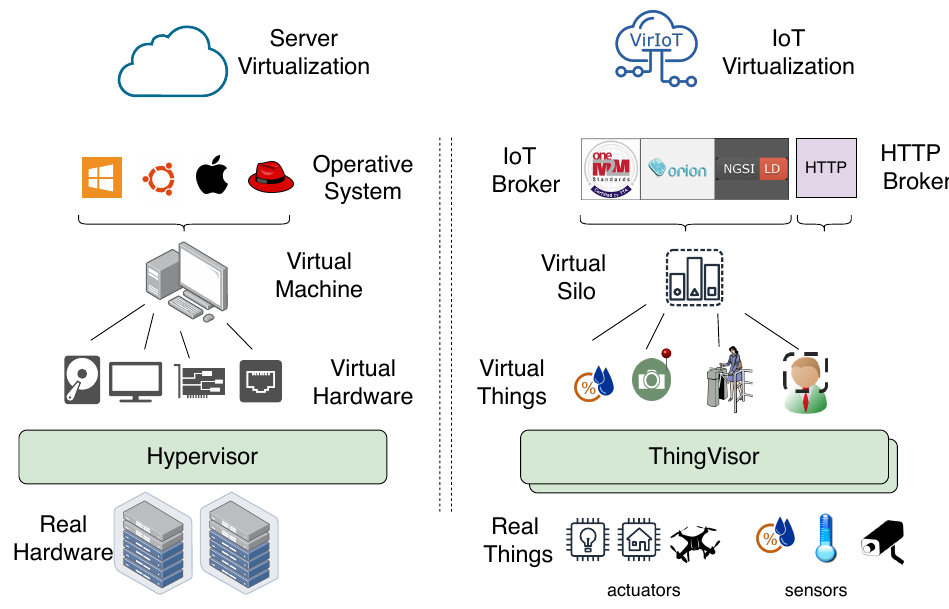
Figure 3. Server Virtualization vs. IoT